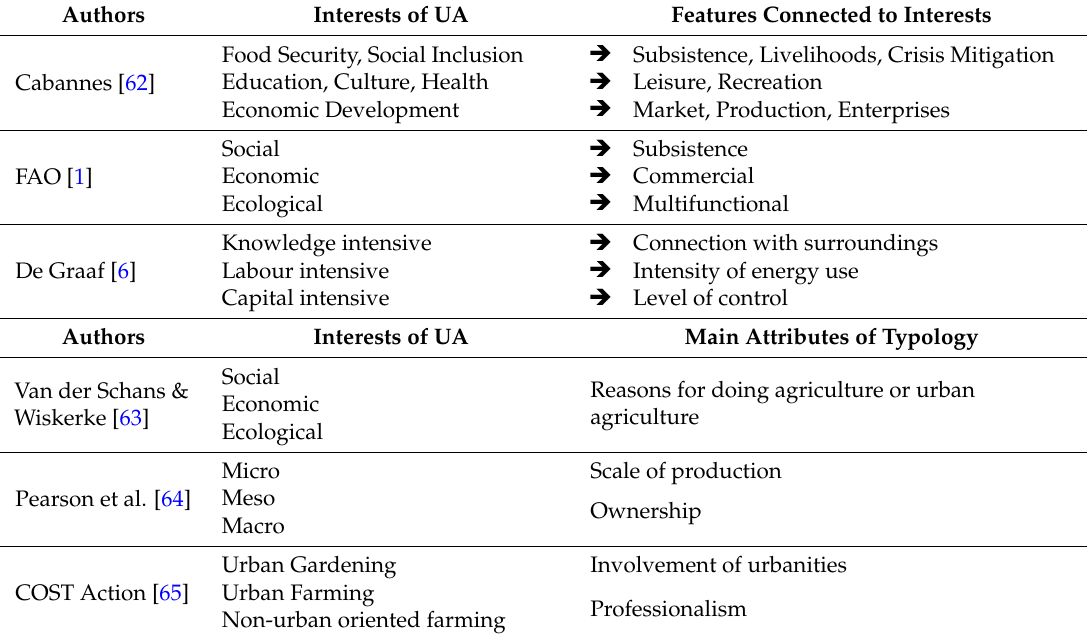
Table 1. Typologies for Urban Agriculture (UA), Including Interests of UA and Their Relevant Features and Attributes. FAO [1]